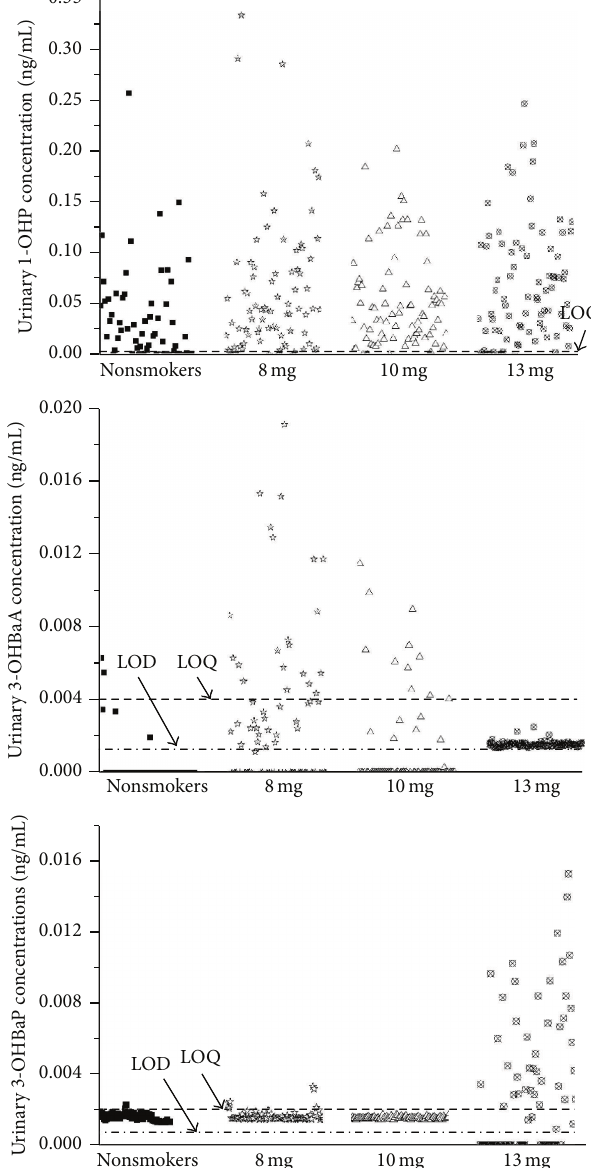
Figure 3: Urinary 1-OHP, 3-OHBaA, and 3-OHBaP concentrations from nonsmokers and